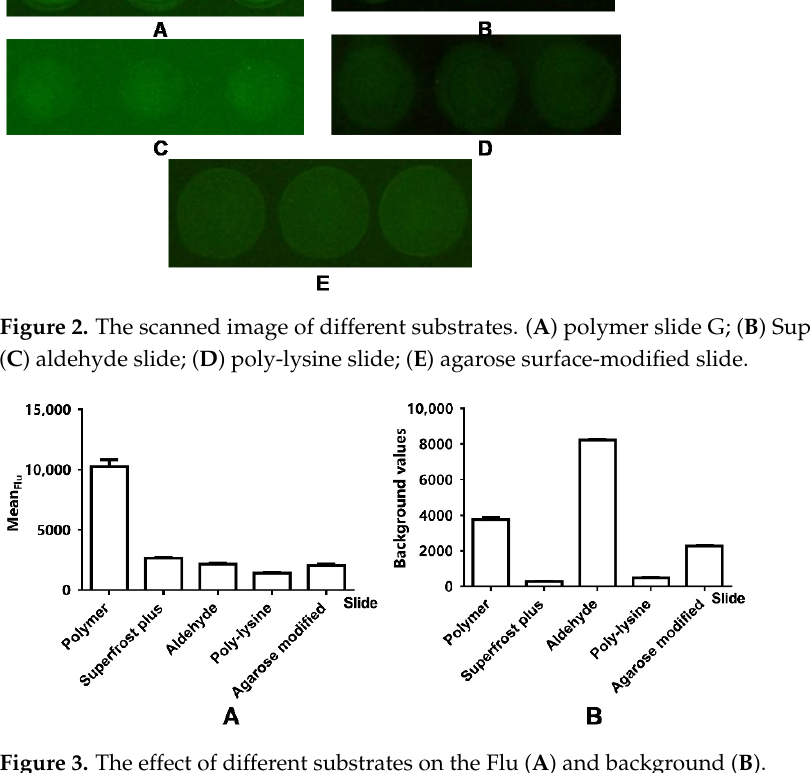
Figure 3. The effect of different substrates on the Flu ( A ) and background ( B ).